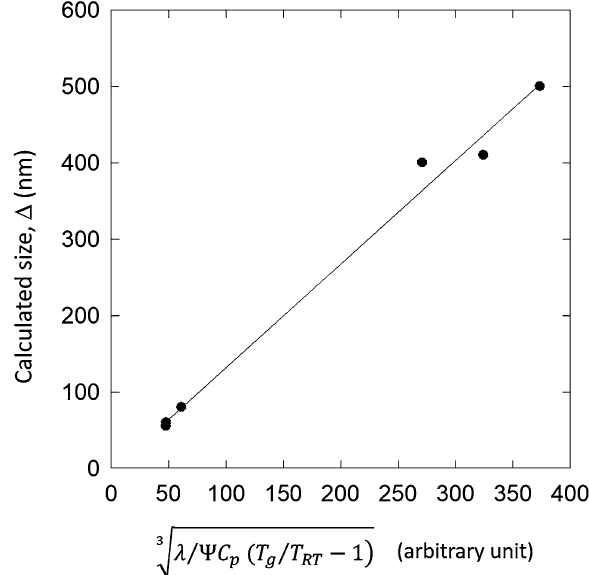
Figure 4. Dependence of the critical size (cid:31) with the glass transition temperature T g